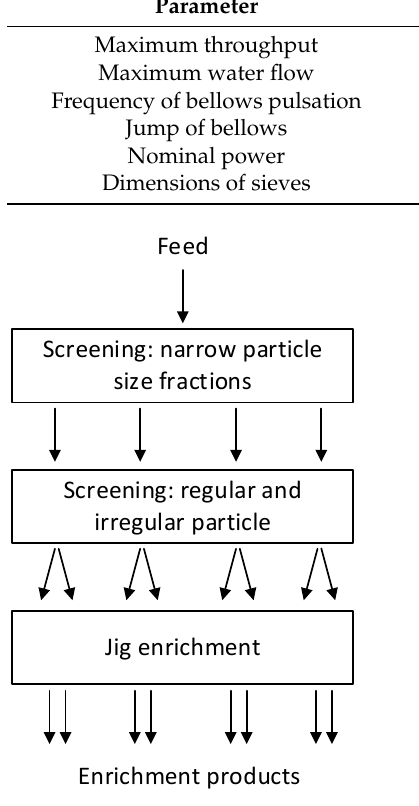
Figure 3. The screening and beneficiation scheme.